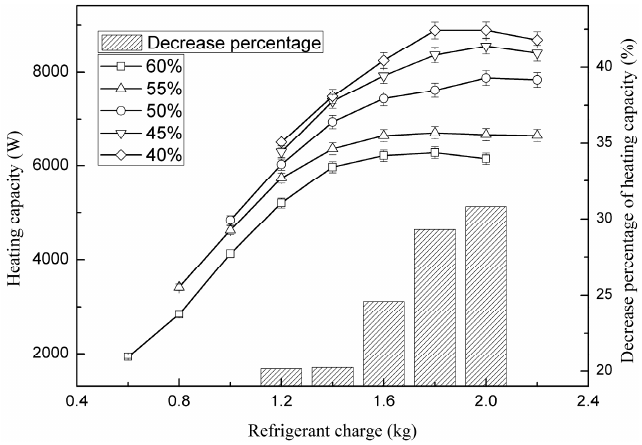
Figure 2. Variations of heating capacity with refrigerant charge and EEV opening.